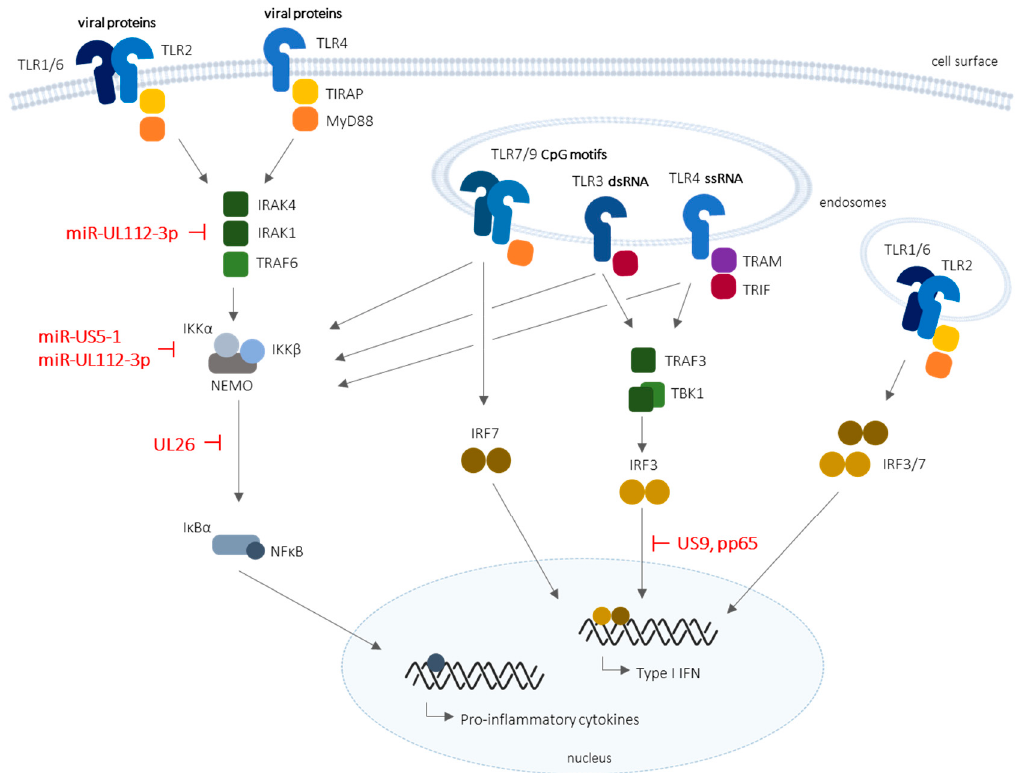
Figure 1. Schematic representation of Toll-like receptor (TLR) signaling and corresponding evasion mechanisms developed by the human cytomegalovirus (HCMV). TLR2 and TLR4 are present on the cell surface, and are directly stimulated or internalized upon activation, whereas TLR3 and TLR7/8 are localized in intracellular endosomes. HCMV microRNAs (miR-UL112-3p and miRUS5-1), as well as HCMV (UL26, US9, and pp65) proteins, are known to inhibit specific or broad antiviral mechanisms downstream of TLR recognition, in particular nuclear factor kappa B (NF- κ B) and interferon (IFN) regulatory factor 3 (IRF3)-mediated type I IFN production. I κ B α : NF- κ B inhibitor;